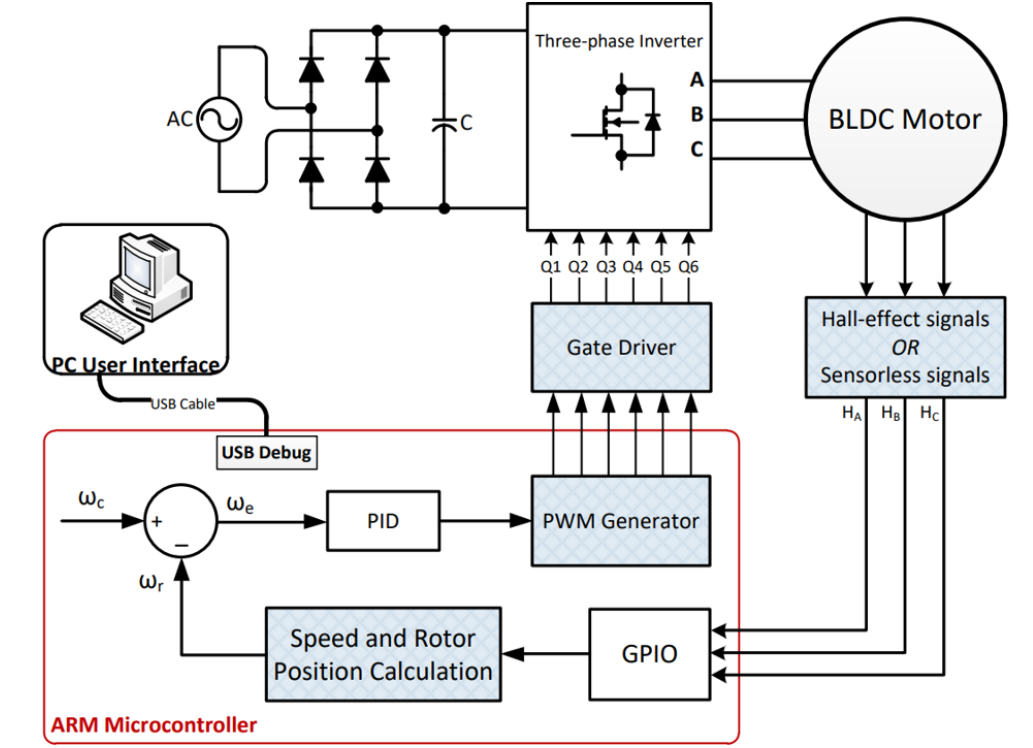
Figure 7. Typical electric drive architecture for mechatronic